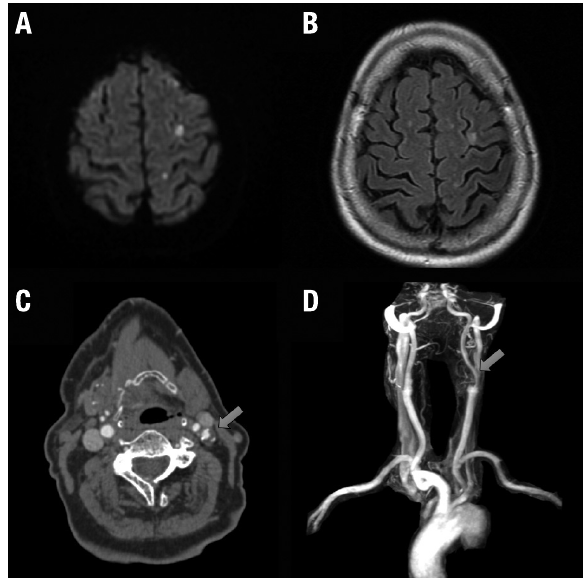
Figure 1. Diffusion-weighted imaging (A) and T2-FLAIR (B) MRI showing multiple small hyperintense foci in the middle frontal and post central gyri. Computer Tomography Angiography (C) and MR Angiography (D) showing mild atheromatosis in both carotid arteries. The left atheroscle- rotic plaque is soft and ulcerated, causing vessel stenosis of approxi- mately